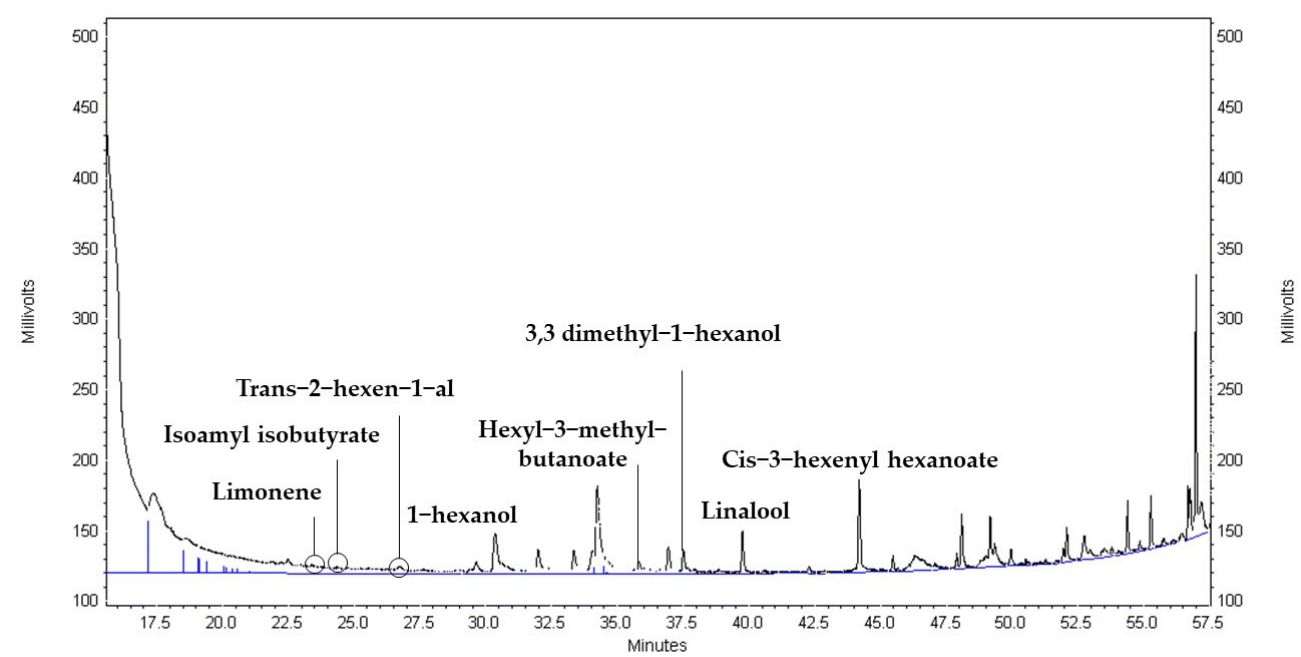
Figure A2. Chromatogram of the sample WIL 48 h.